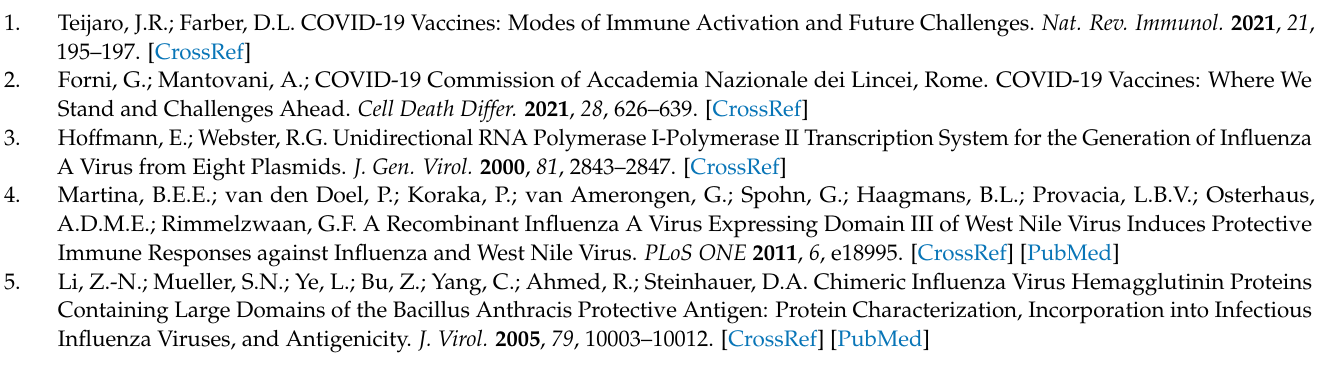
(RBD) of SARS-CoV-2 spike protein. Figure S2: Verification of RBD-M2 and mCherry-M2 insertion in the HA-encoding segment via